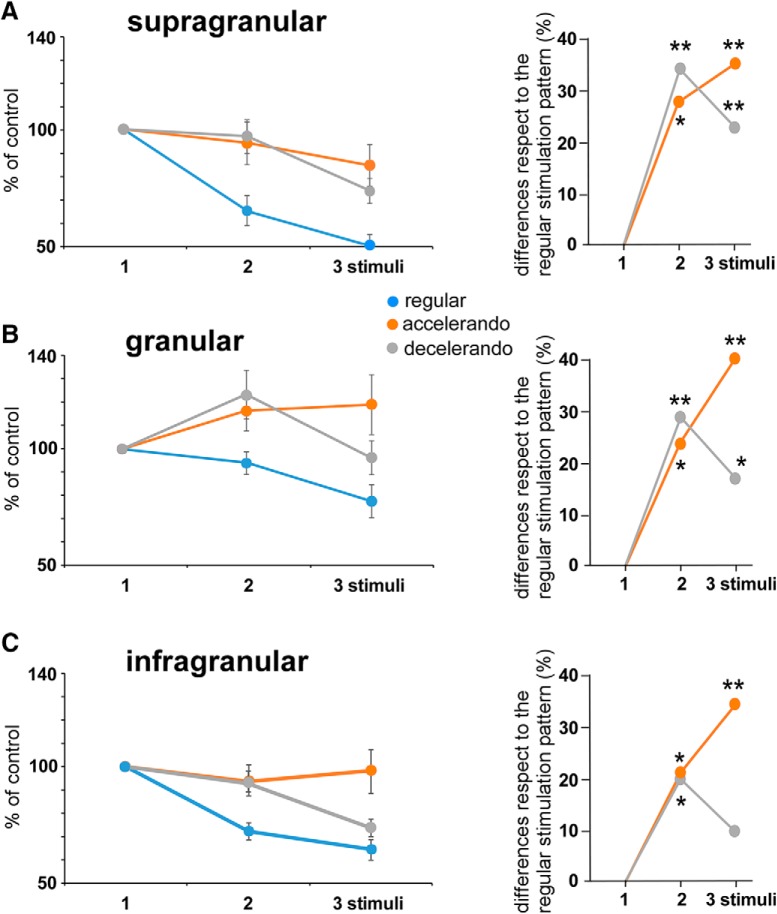
Response adaptation is altered by a change in the stimulation pattern. A, Supragranular neurons (n = 14) show a reduction in spike response during the application of the regular stimulation pattern (three stimuli at 4 Hz; blue circles). The mean percentage of the response respect to the control stimulus (first stimulus of the stimulation train) is shown on the left. The response adaptation is reduced if the interval between the first and the second stimuli increases from 250 to 375 ms (accelerando stimulation pattern; orange circle) or decreases to 125 ms (decelerando stimulation pattern; gray circle). The plots shown on the right display differences in the percentage of responses to the 1–3 stimuli during the application of the accelerando or decelerando stimulation patterns respect to the corresponding percentage to the 1–3 stimuli during the application of a regular stimulation pattern. In all cases the response to the second and third stimuli is higher than is expected during the regular stimulation pattern. B, C, Same plots as in A from granular (n = 12) and infragranular (n = 23) neurons, respectively. Equally, responses during the accelerando or decelerando stimulation pattern are greater respect to the corresponding response during the application of a regular stimulation pattern. *p < 0.05; **p < 0.01. Figure Contributions: Natali Barros-Zulaica performed the experiments. All authors analyzed the data.